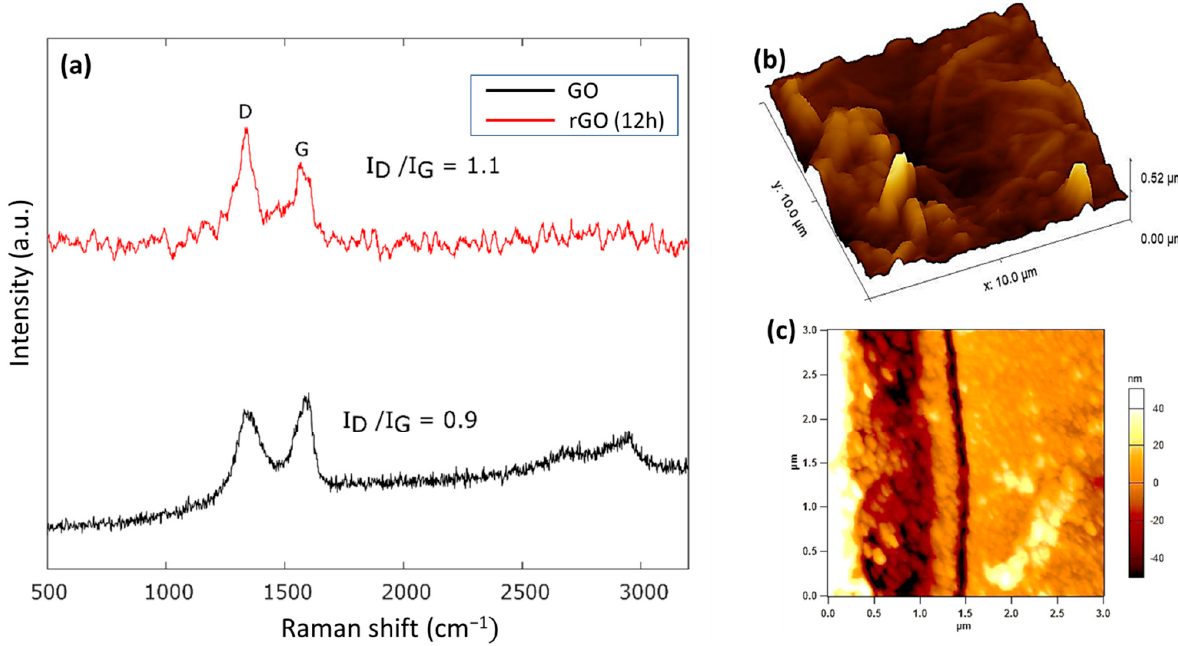
Figure 4. ( a ) Raman spectra of GO and rGO reduced for 12 h on COC substrate. ( b ) Surface morphology of GO layer as deposited on COC substrate; the root-mean-square roughness is measured at 62 nm. ( c ) AFM image of GO; the thickness of GO can be estimated as 100 nm.